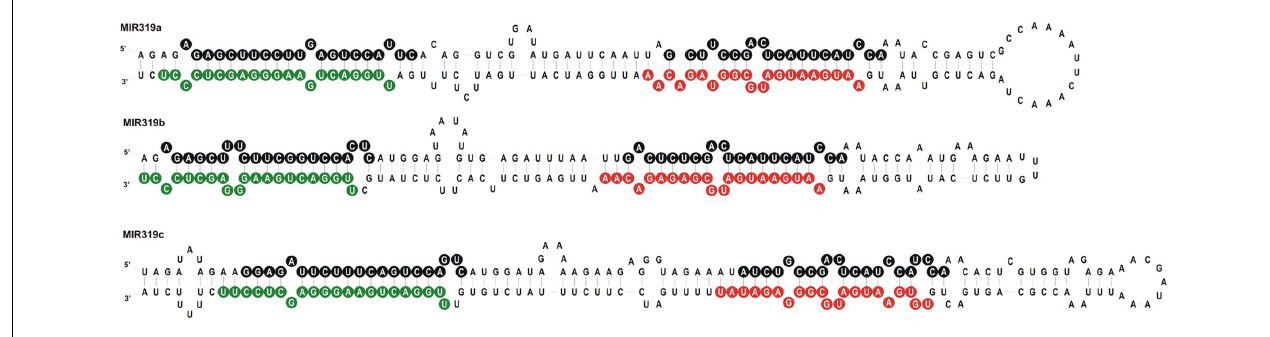
FIGURE 1 | Stem and loop structures of Arabidopsis pre-miR319 precursors. Sequences of miR319a, b, and c are in green, sequences representing miRNA319a.2, b.2, and c.2 are in red, and star sequences are in black circles, respectively.